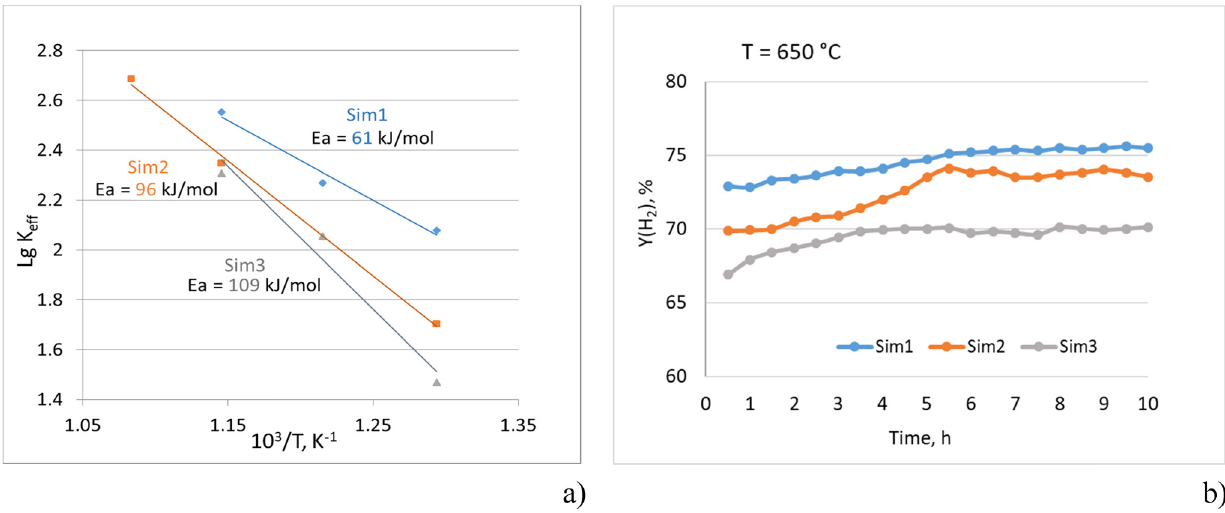
Figure 7: ( a ) Linearized Arrhenius equation and activation energy E a and ( b ) hydrogen yield at 650°C in time - on - stream ethanol steam reforming